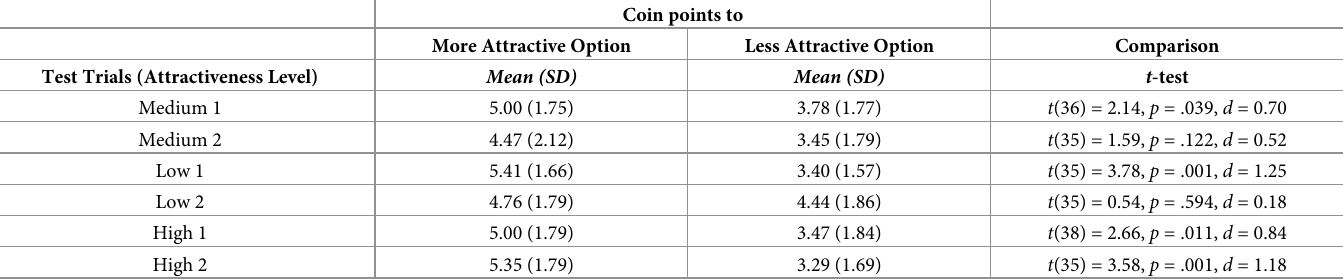
Table 5. Affective reactions (means and standard deviations) in Study 2 depending on whether the coin flip suggested the previously more or less attractively rated option.